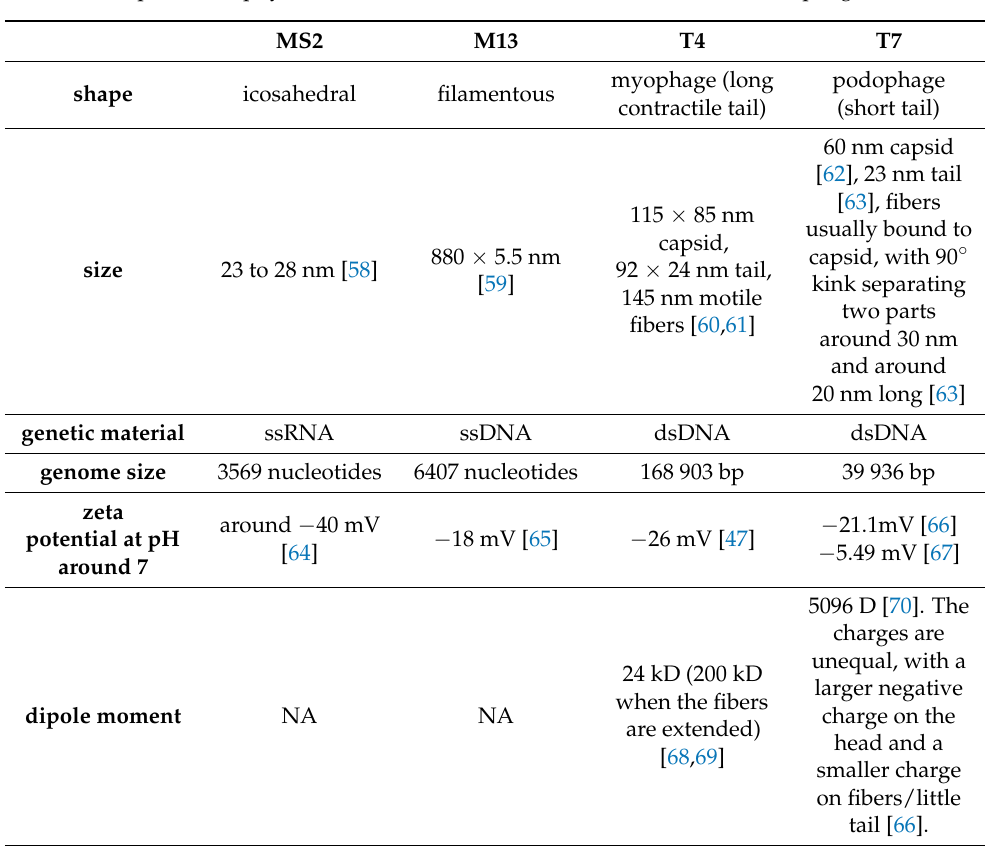
Table 1. Comparison of physical characteristics of MS2, M13, T4, and T7